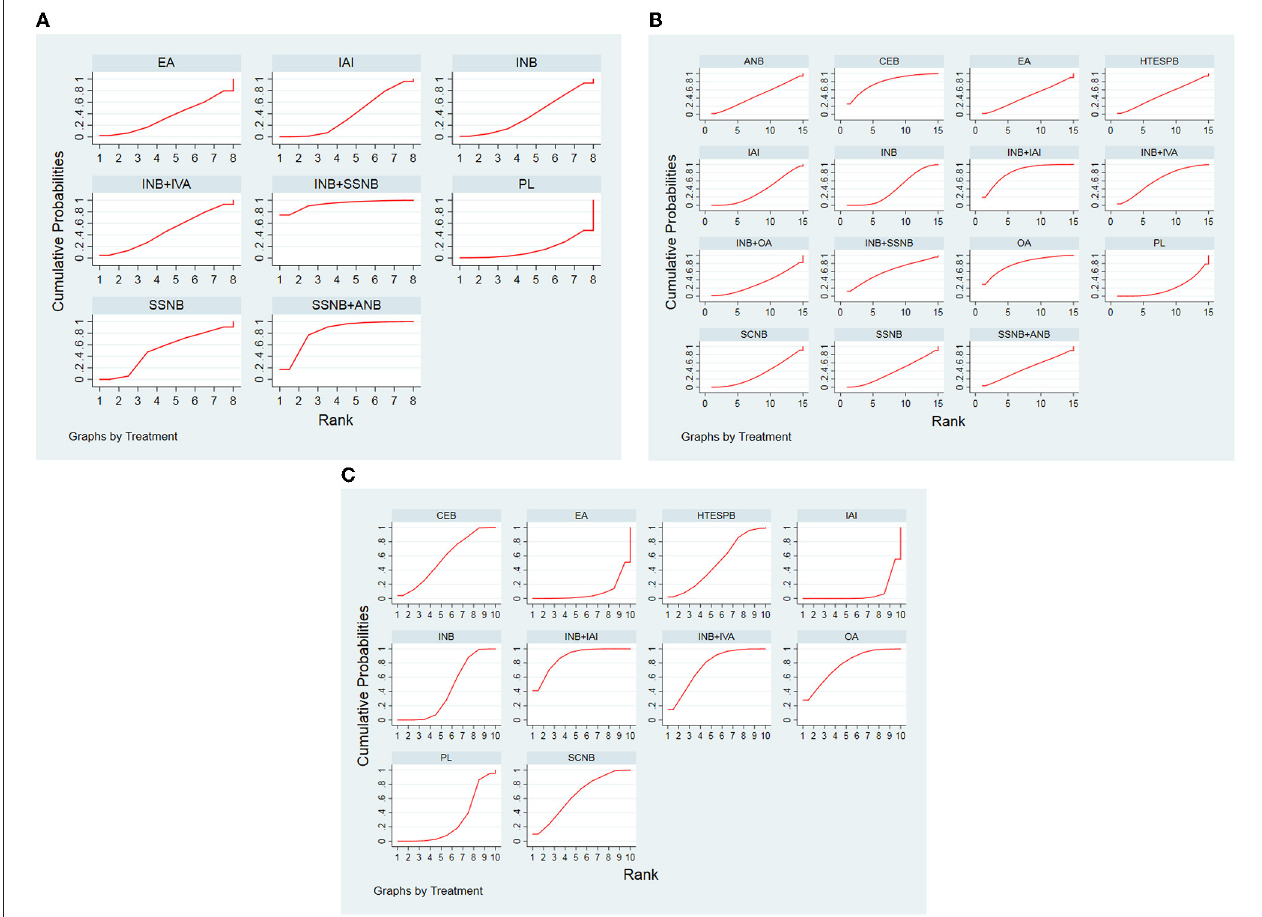
FIGURE 7 | (A) SUCRA for results of postoperative 12h. (B) SUCRA for results of postoperative 24h. (C) SUCRA for results of postoperative 48h. ( After removing the article with less than 40 people ). The area under the curve represents the cumulative rank probability of each treatment; with larger areas signifying higher probabilities. INB, interscalene nerve block; SCNB, supraclavicular nerve block; SSNB, suprascapular nerve block; HTESPB, high thoracic erector spinae plane block; CEB, cervical epidural block; ANB, axillary nerve block; IAI, intra-articular injection; OA, oral administration; EA, external application; IVA, intravenous administration; PL, placebo.